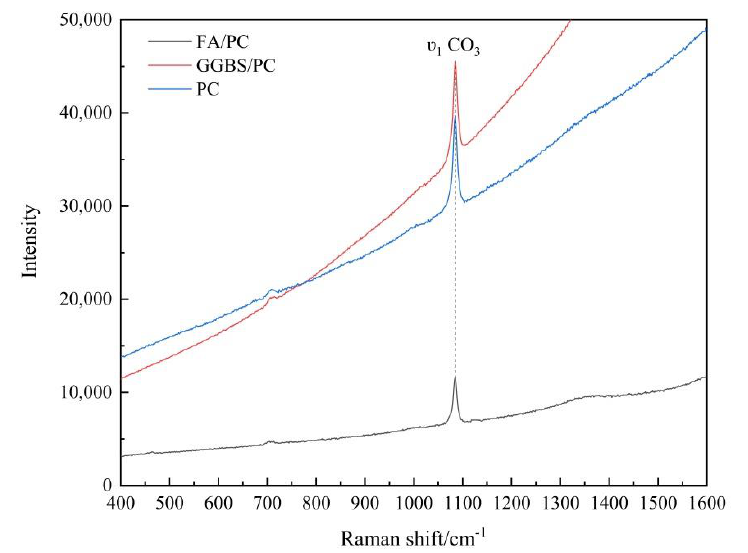
Figure 3. Raman spectra of the powders collected at a depth of 0–2 mm of the carbonated FA/PC, GGBS/PC and PC paste samples. Table 2. Summary of the signal, noise and signal-to-noise ratio (SNR) of the Raman spectra of the powders collected at a depth of 0 – 2 mm of the carbonated FA/PC, GGBS/PC and PC paste sam- ples.